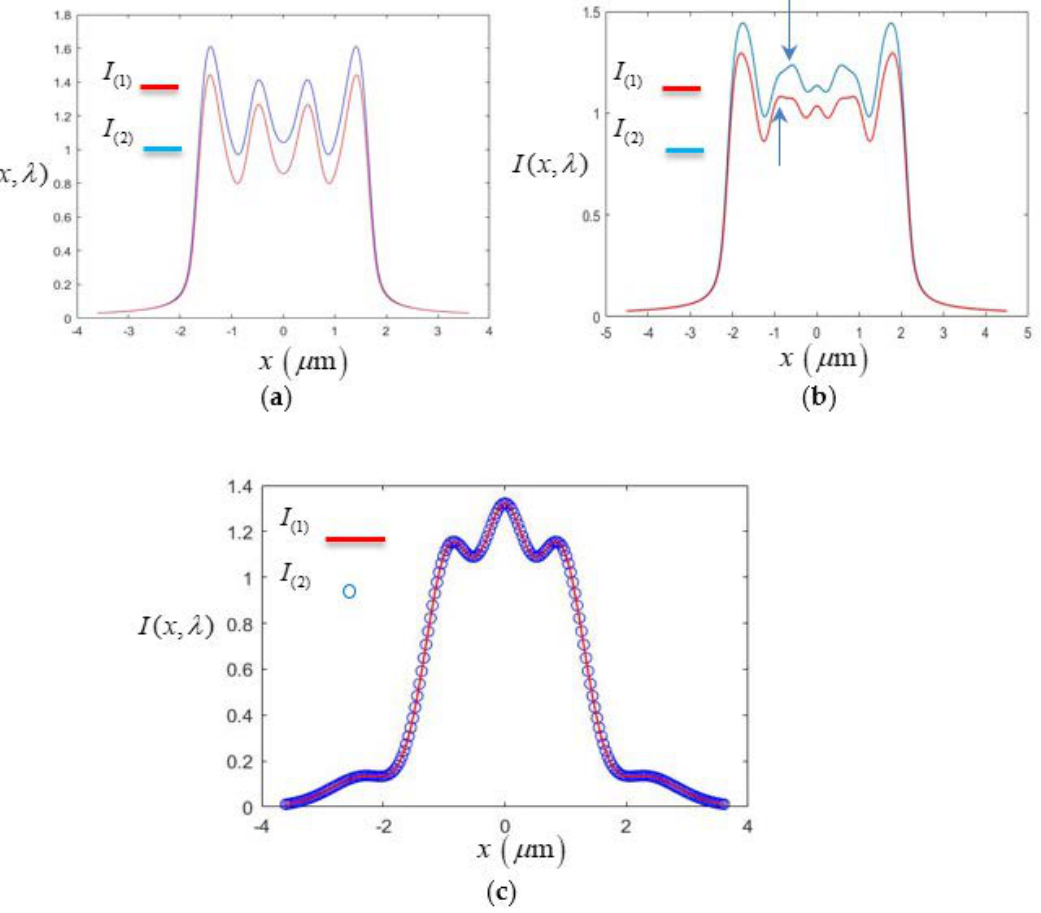
Figure 5. Di ff raction intensity of I ( 1 ) ( x , λ ) and I ( 2 ) ( x , λ ) : ( a ) z = 0.1 µ m (Zone 1) and λ = 1.0 µ m; ( b ) z = 0.1 µ m (Zone 1) and λ = 0.8 µ m; and ( c ) z = 2.5 µ m(Zone 2) and λ = 1.0 µ